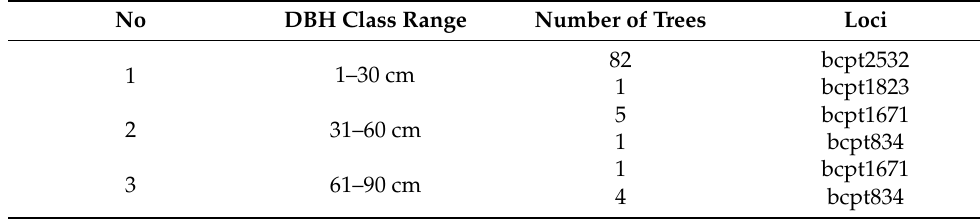
Table A1. Number of private alleles within Iki-no-Matsubara.